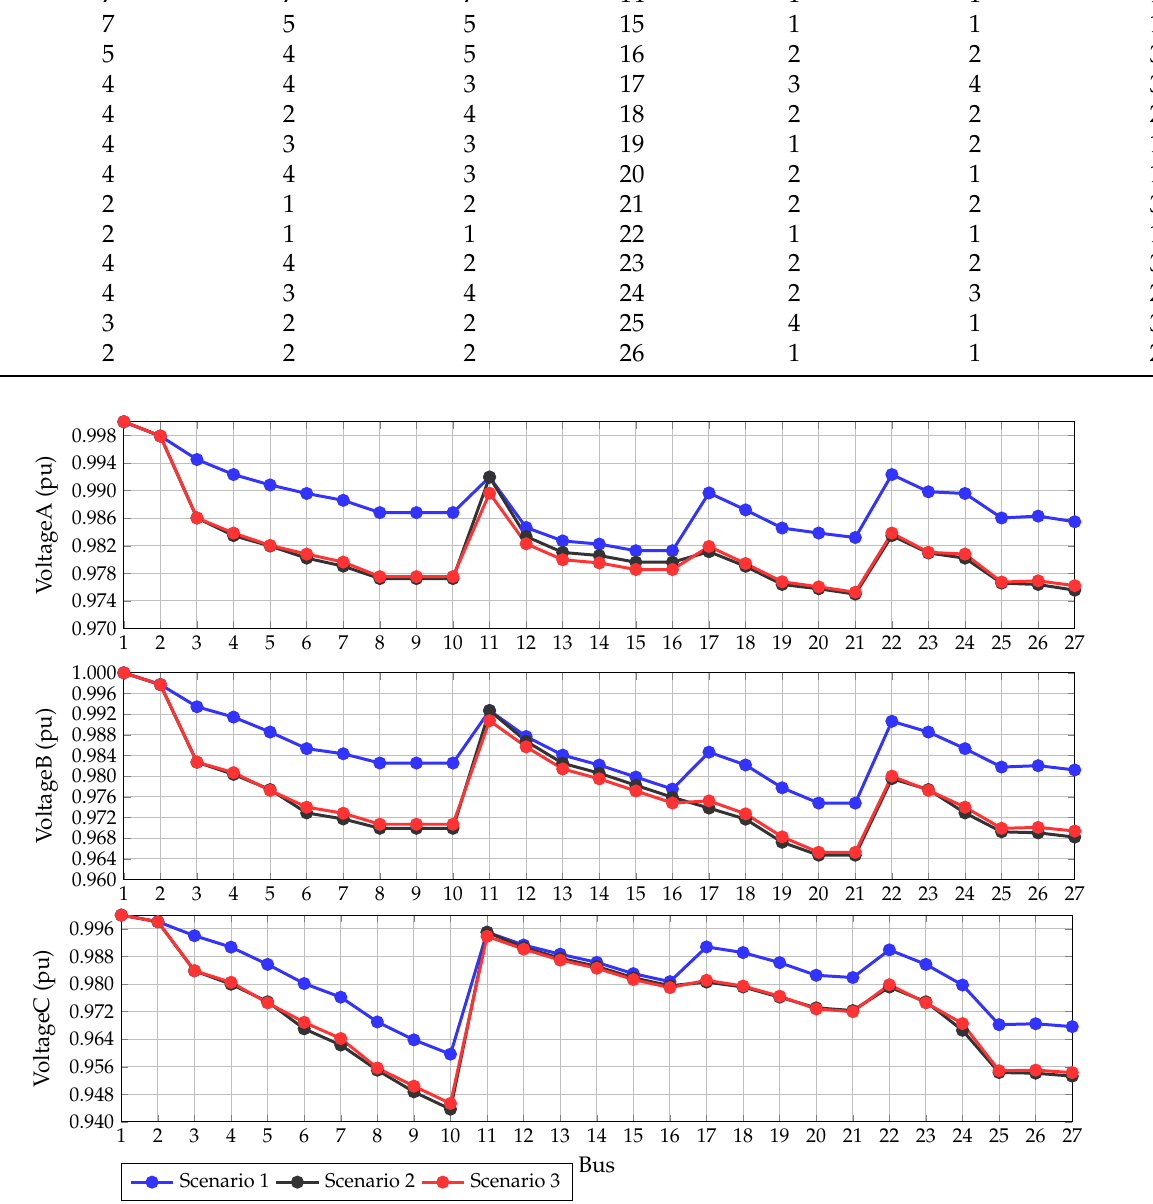
Figure 10. Voltage profile at each node for the hour of maximum demand in the three stages of case 2 of test system